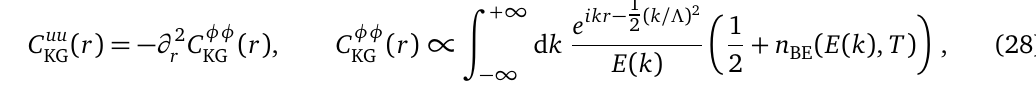
choice of parameter values c = 1, M = 1, T = 0 and various values of the high- two sides of the central